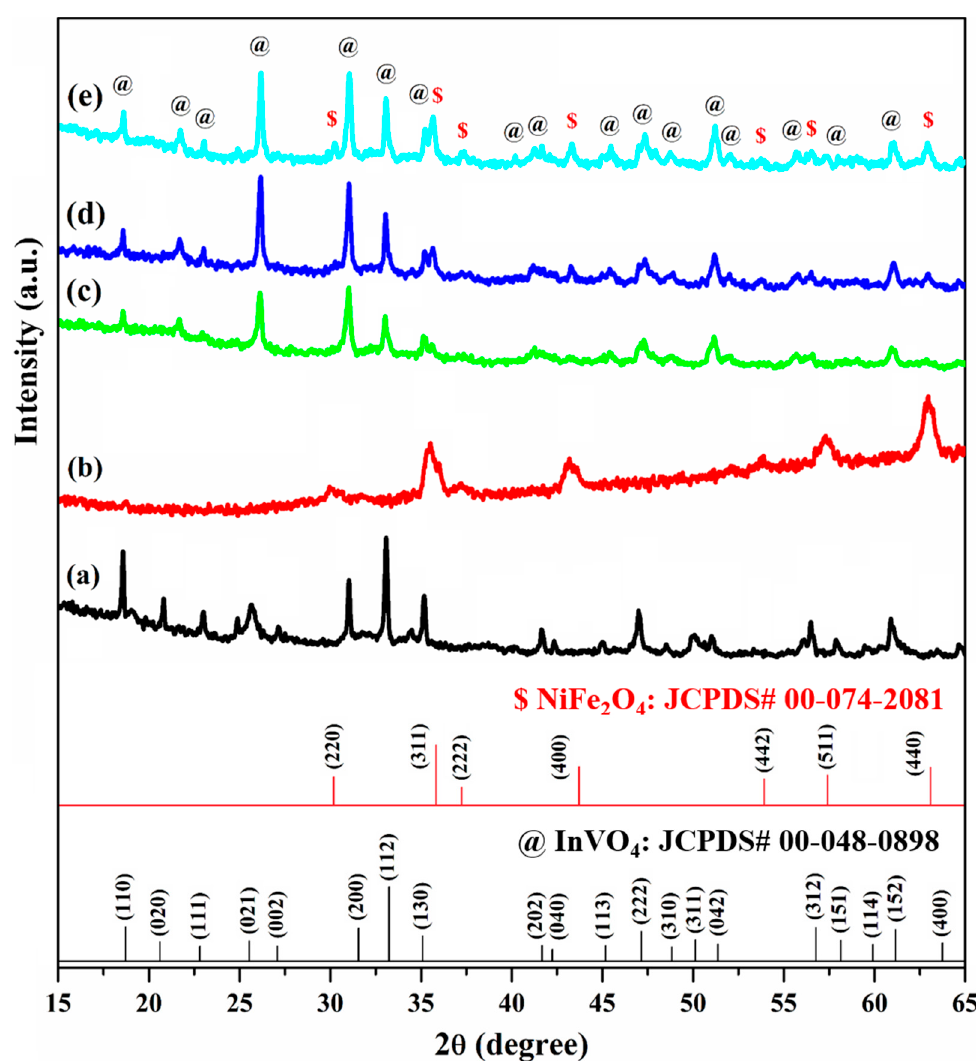
Figure 1. X-ray diffraction patterns of ( a ) InVO 4 , ( b ) NiFe 2 O 4 , ( c ) IVNF-2.5, ( d ) IVNF-5.0, and ( e ) IVNF-7.5